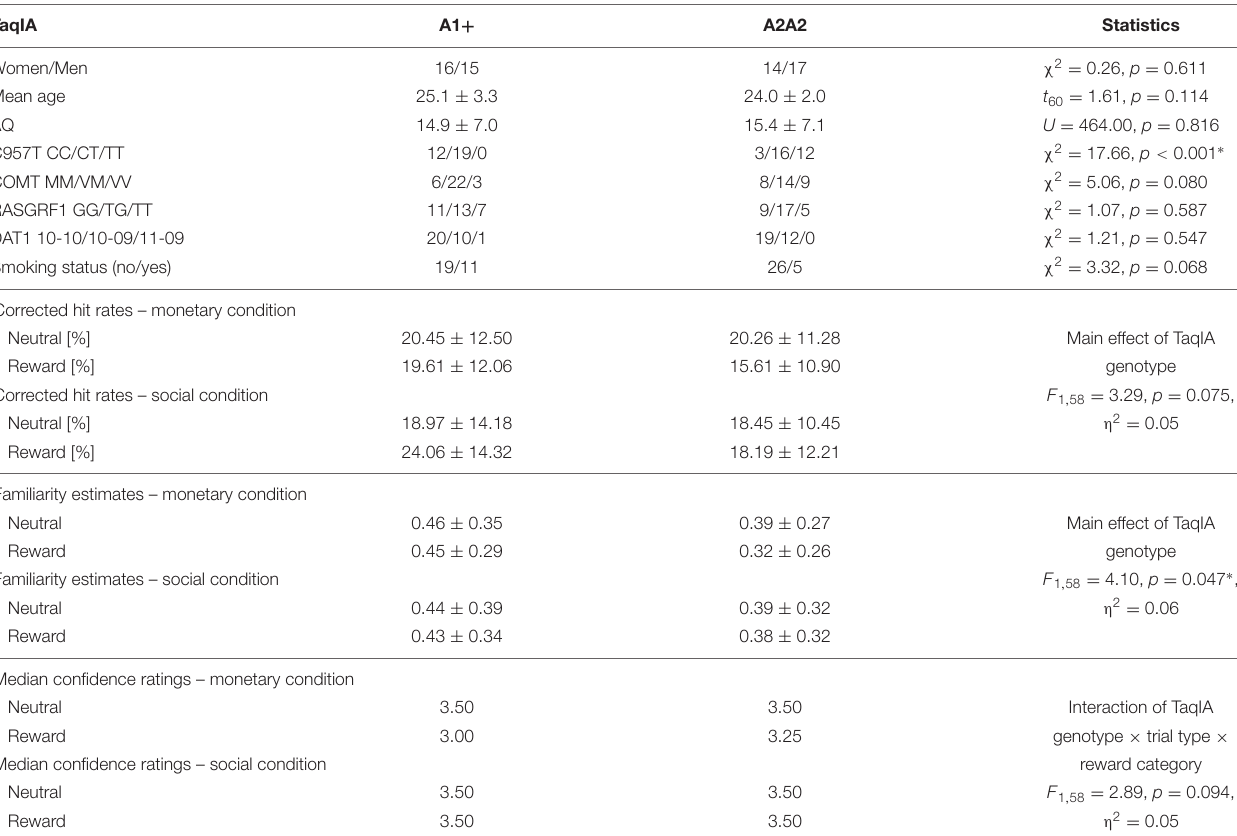
TABLE 1 | Demographic data and behavioral data of the memory parameters regarding TaqIA polymorphism. TaqIA A1